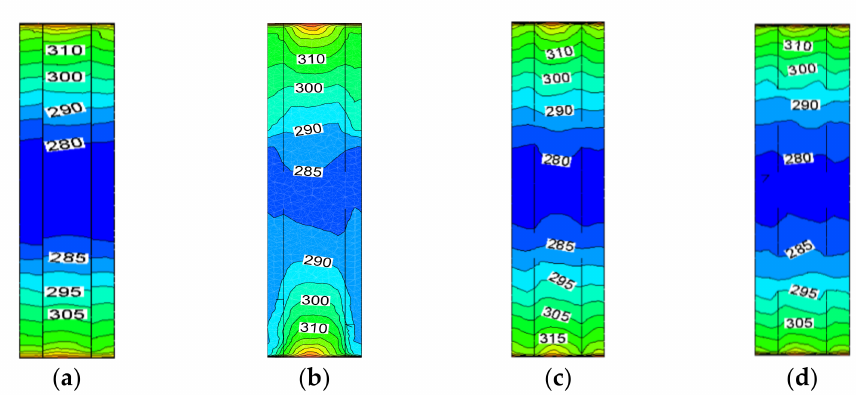
Figure 16. Temperature distributions at the Z-axis central section in five cases at Re = 27,900. ( a ) BP case; ( b ) one-circle case; ( c ) two-circle case; ( d ) three-circle case.